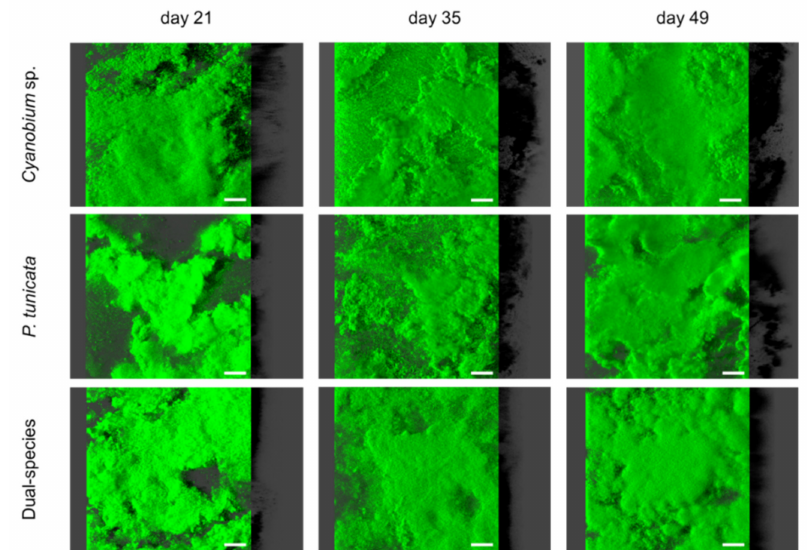
Figure 3. 3D projections of single- ( Cyanobium sp. and P. tunicata ) and dual-species biofilms formed on gel-coated glass surfaces after 21, 35, and 49 days. The representative images were obtained from confocal z -stacks using IMARIS software and present an aerial view of the biofilms (shadow projection on the right). The white scale bar corresponds to 50 µ